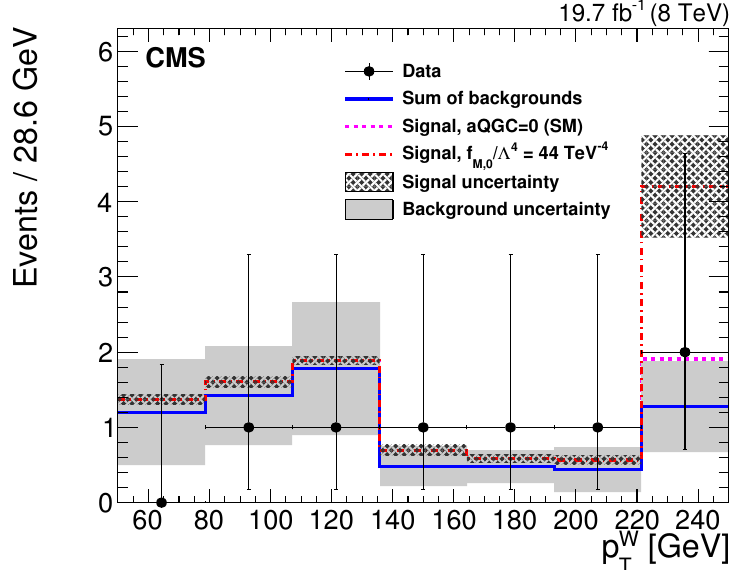
Figure 4 . Comparison of predicted and observed p W distributions with the combined electron T and muon channels. The last p W bin has been extended to include the over(cid:13)ow contribution. The T dash-dotted line depicts a representative signal distribution with anomalous coupling parameter f M; 0 = (cid:3) 4 = 44 TeV (cid:0) 4 and the dashed line shows the same distribution corresponding to the SM case. The bands represent the statistical and systematic uncertainties in signal and background predictions summed in quadrature. The data are shown with statistical uncertainties